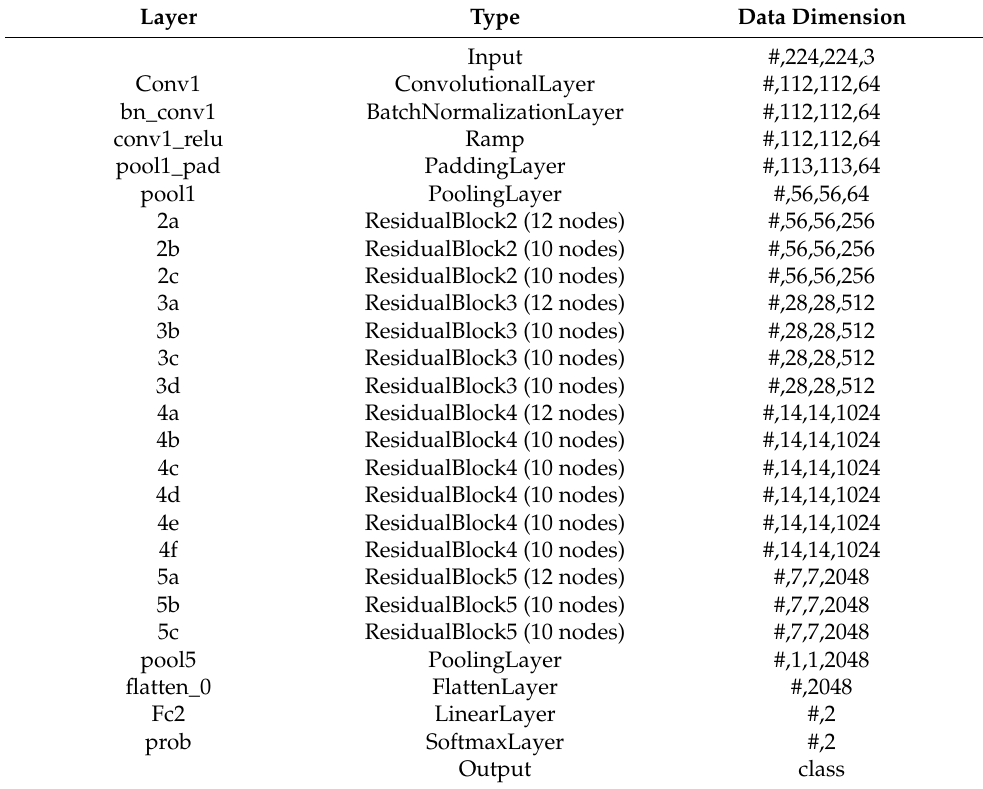
Table 1. Detailed configuration of ResNet50